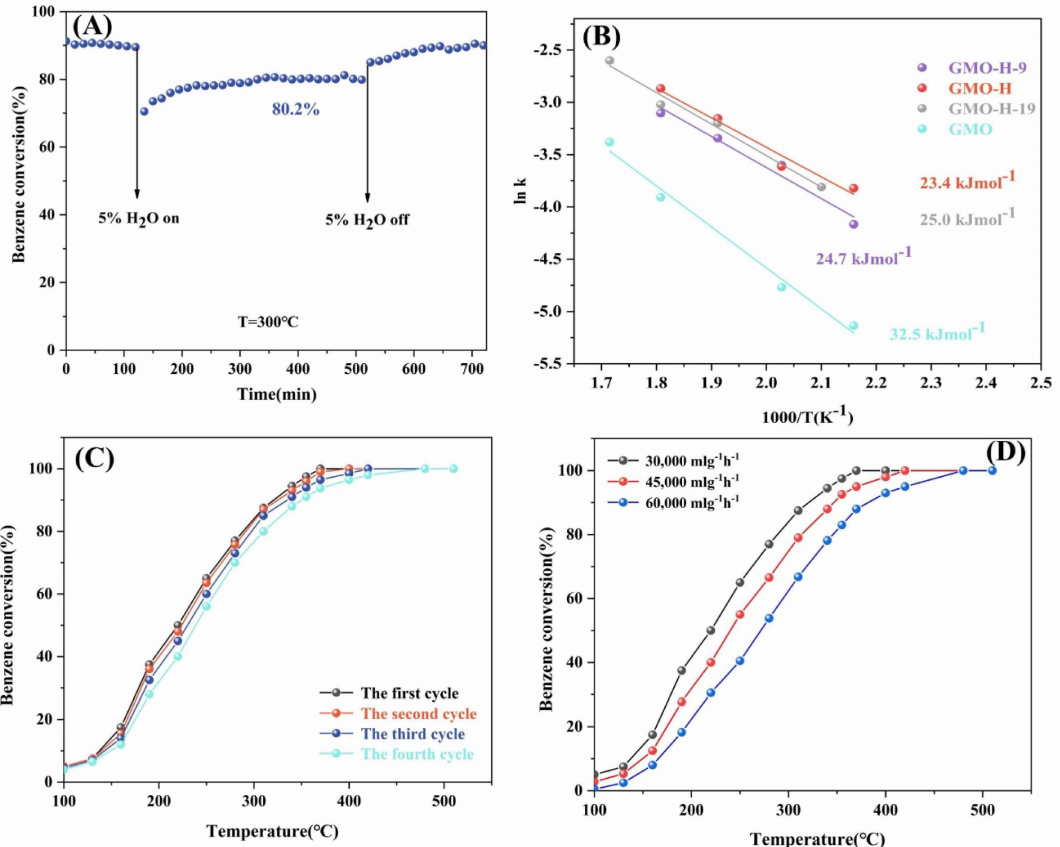
Figure 7. ( A ) Water resistance of GMO-H at 300 ◦ C.; ( B ) Arrhenius plots of catalysts for the catalytic combustion of Benzene; ( C ) Four-cycle test performance of GMO-H (reaction conditions: 0.10 g catalyst, 600 ppm C 6 H 6 , 20% O 2 , N 2 balance, total flow = 50 mL min − 1 , WHSV = 30,000 mL g − 1 h − 1 ; each point corresponds to steady-state conditions); ( D ) Benzene catalytic activity of GMO-H at different WHSV. The lower E a represented the easier catalytic oxidation of Benzene. The results show that GMO (32.5 kJ mol − 1 ) > GMO-H-19 (25.0 kJ mol − 1 ) > GMO-H-9 (24.7 kJ mol − 1 )